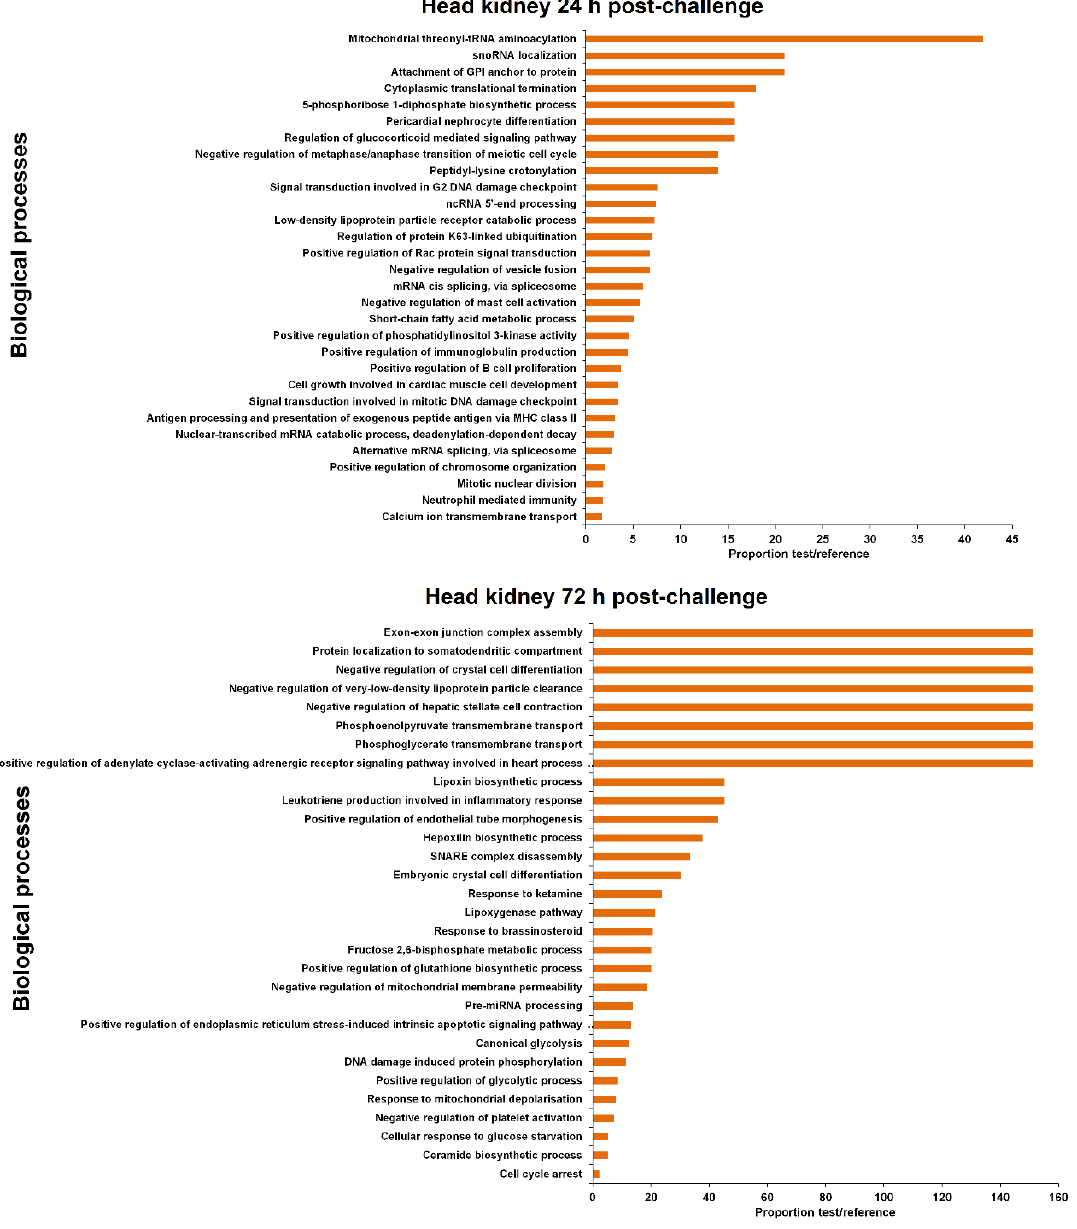
Figure 5. GO enrichment analysis (biological processes) of the neighbouring coding genes of the differentially modulated lncRNAs (FC > 2, FDR < 0.05) in head kidney after viral challenge. Only the 30 most significant terms were represented.